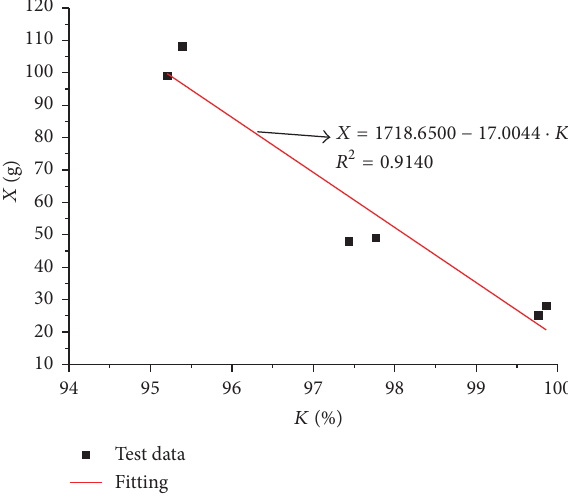
Figure 10: Relation between water absorbing 𝑋 and compaction degree K .